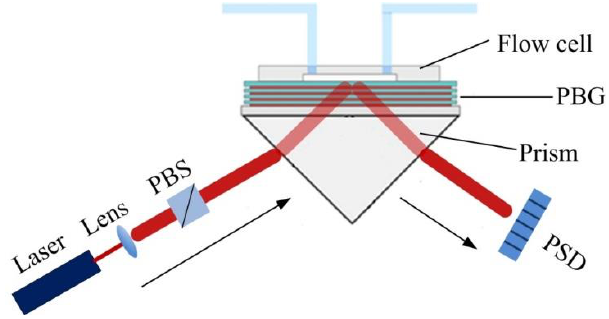
Figure 5. Schematic diagram of the experimental setup.